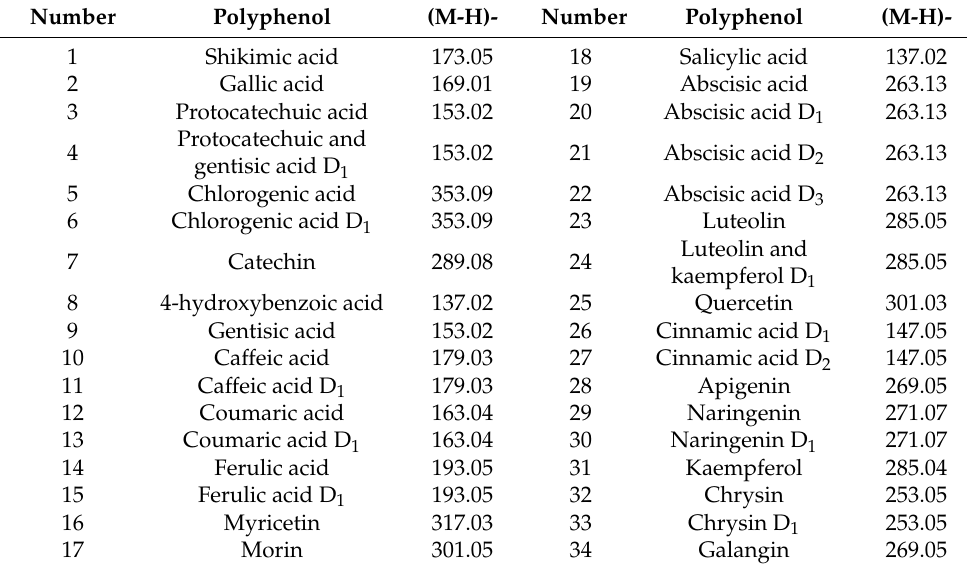
Table 1. The detected polyphenols and their derivatives (D) mass-to-charge ratios ( m / z